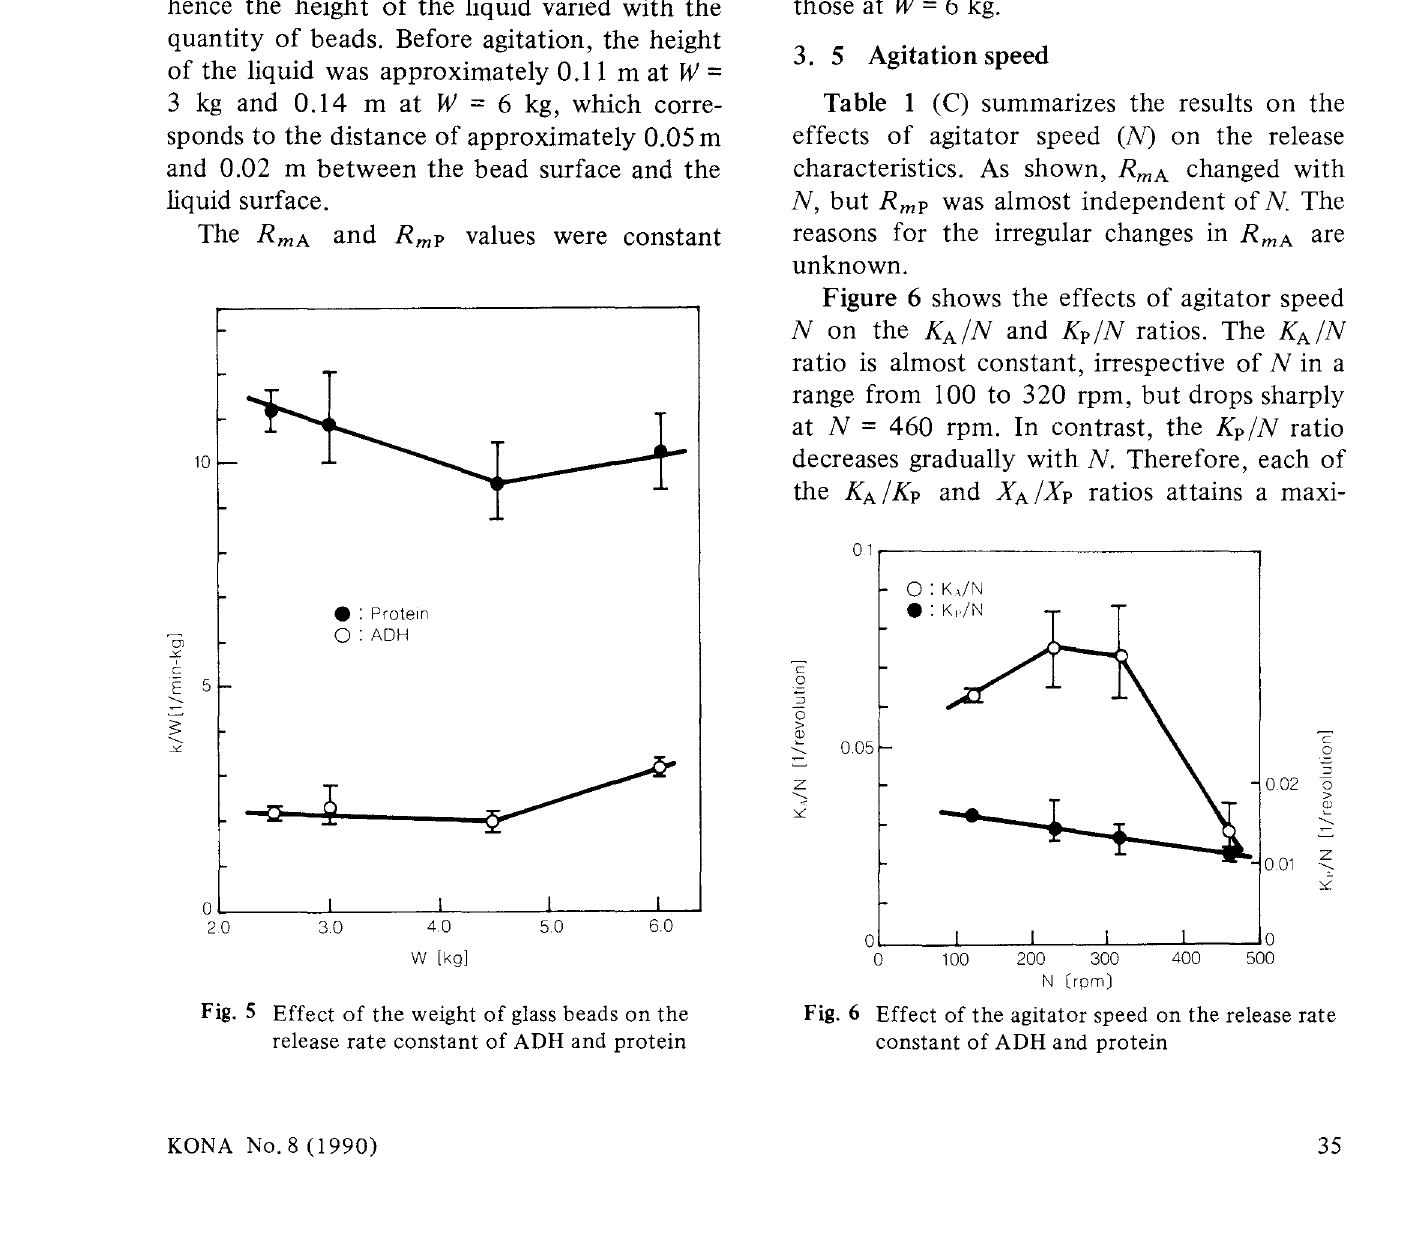
Fig. 5 Effect of the weight of glass beads on the release rate constant of ADH and protein